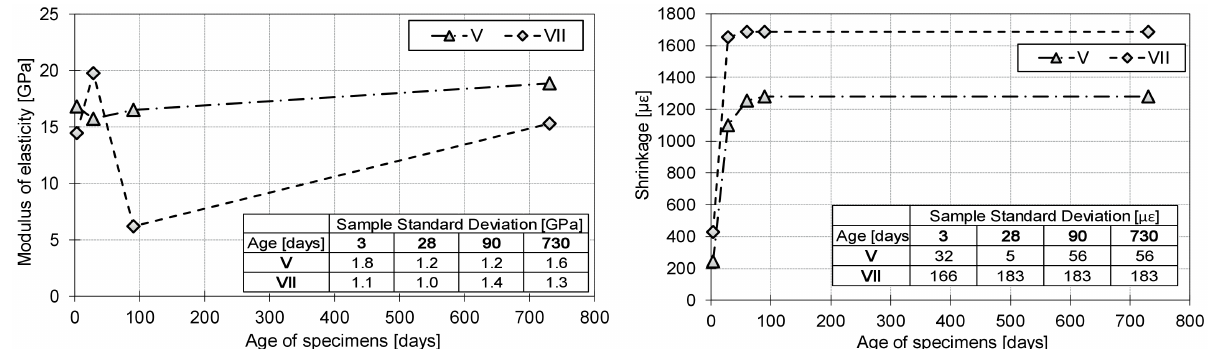
Figure 4. Development of the modulus of elasticity determined from F − d diagrams (left) and the shrinkage process.